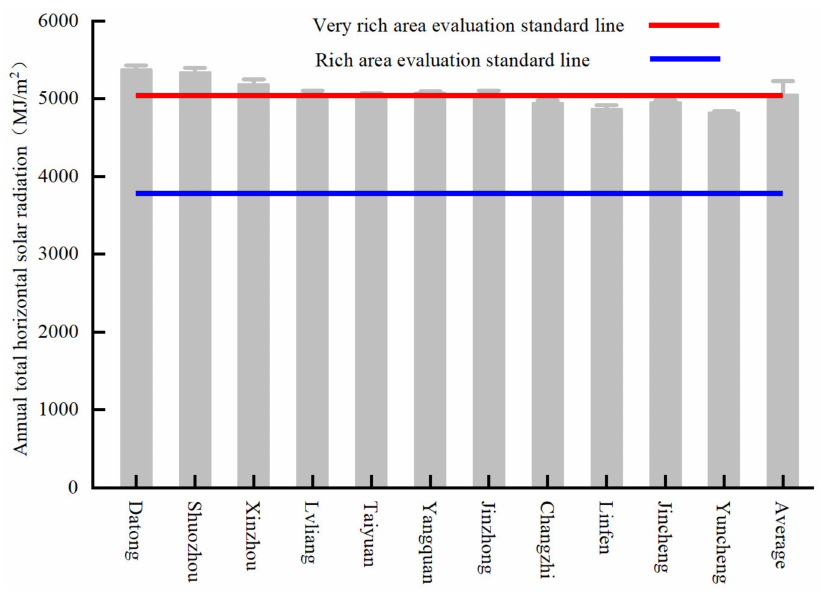
Figure 8. Solar energy resource abundance of cities in Shanxi province. Table 4. Classification of suitable areas for solar energy resources in Shanxi province.